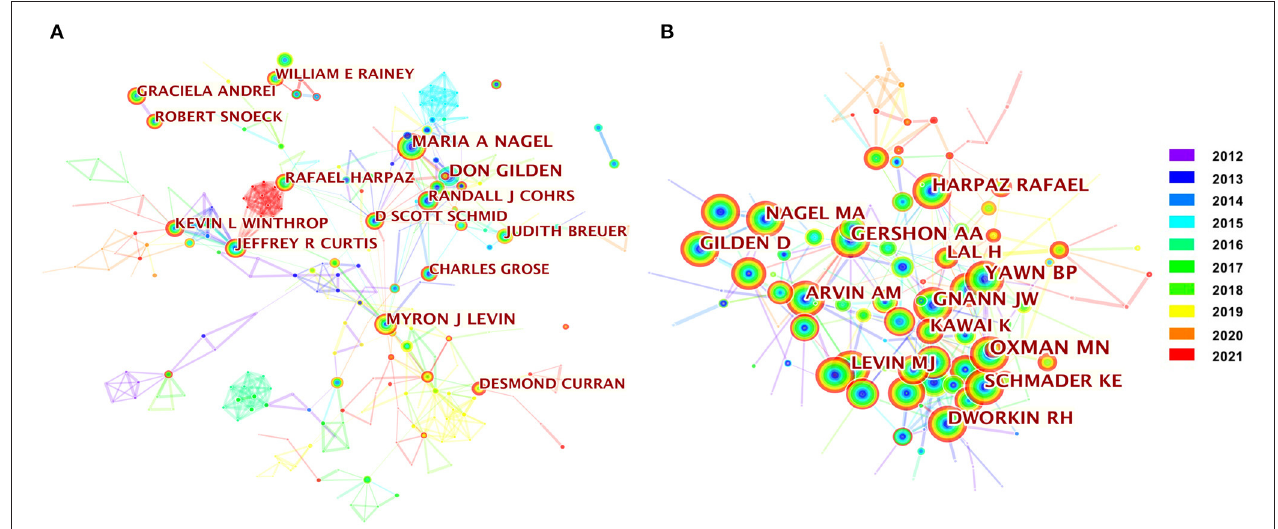
FIGURE 3 | The network map of authors (A) and the co-cited authors (B) map in herpes zoster research.